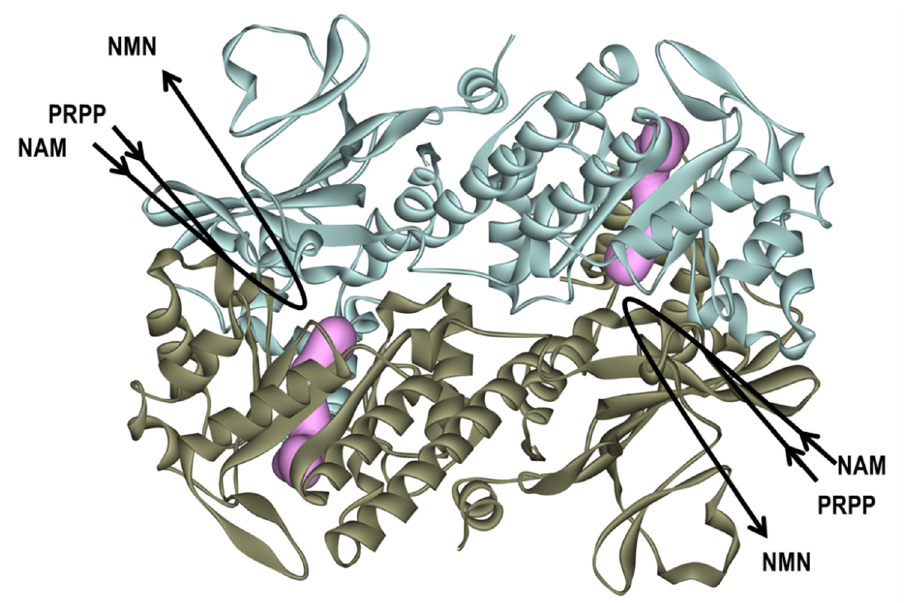
Figure 1. Overview of the human (h) nicotinamide phosphoribosyltransferase (NAMPT) as the dimer form and its enzyme reaction. The homodimer structure of hNAMPT (PDB Code: 2GVJ) [38–42] is shown in the ribbon diagram colored light blue and brown, respectively. The two tunnel-shaped cavities near the active sites in the hNAMPT molecule are shown in magenta shading. NAMPT catalyzes the conversion of nicotinamide (NAM) and phosphoribosyl pyrophosphate (PRPP) to produce nicotinamide mononucleotide (NMN).